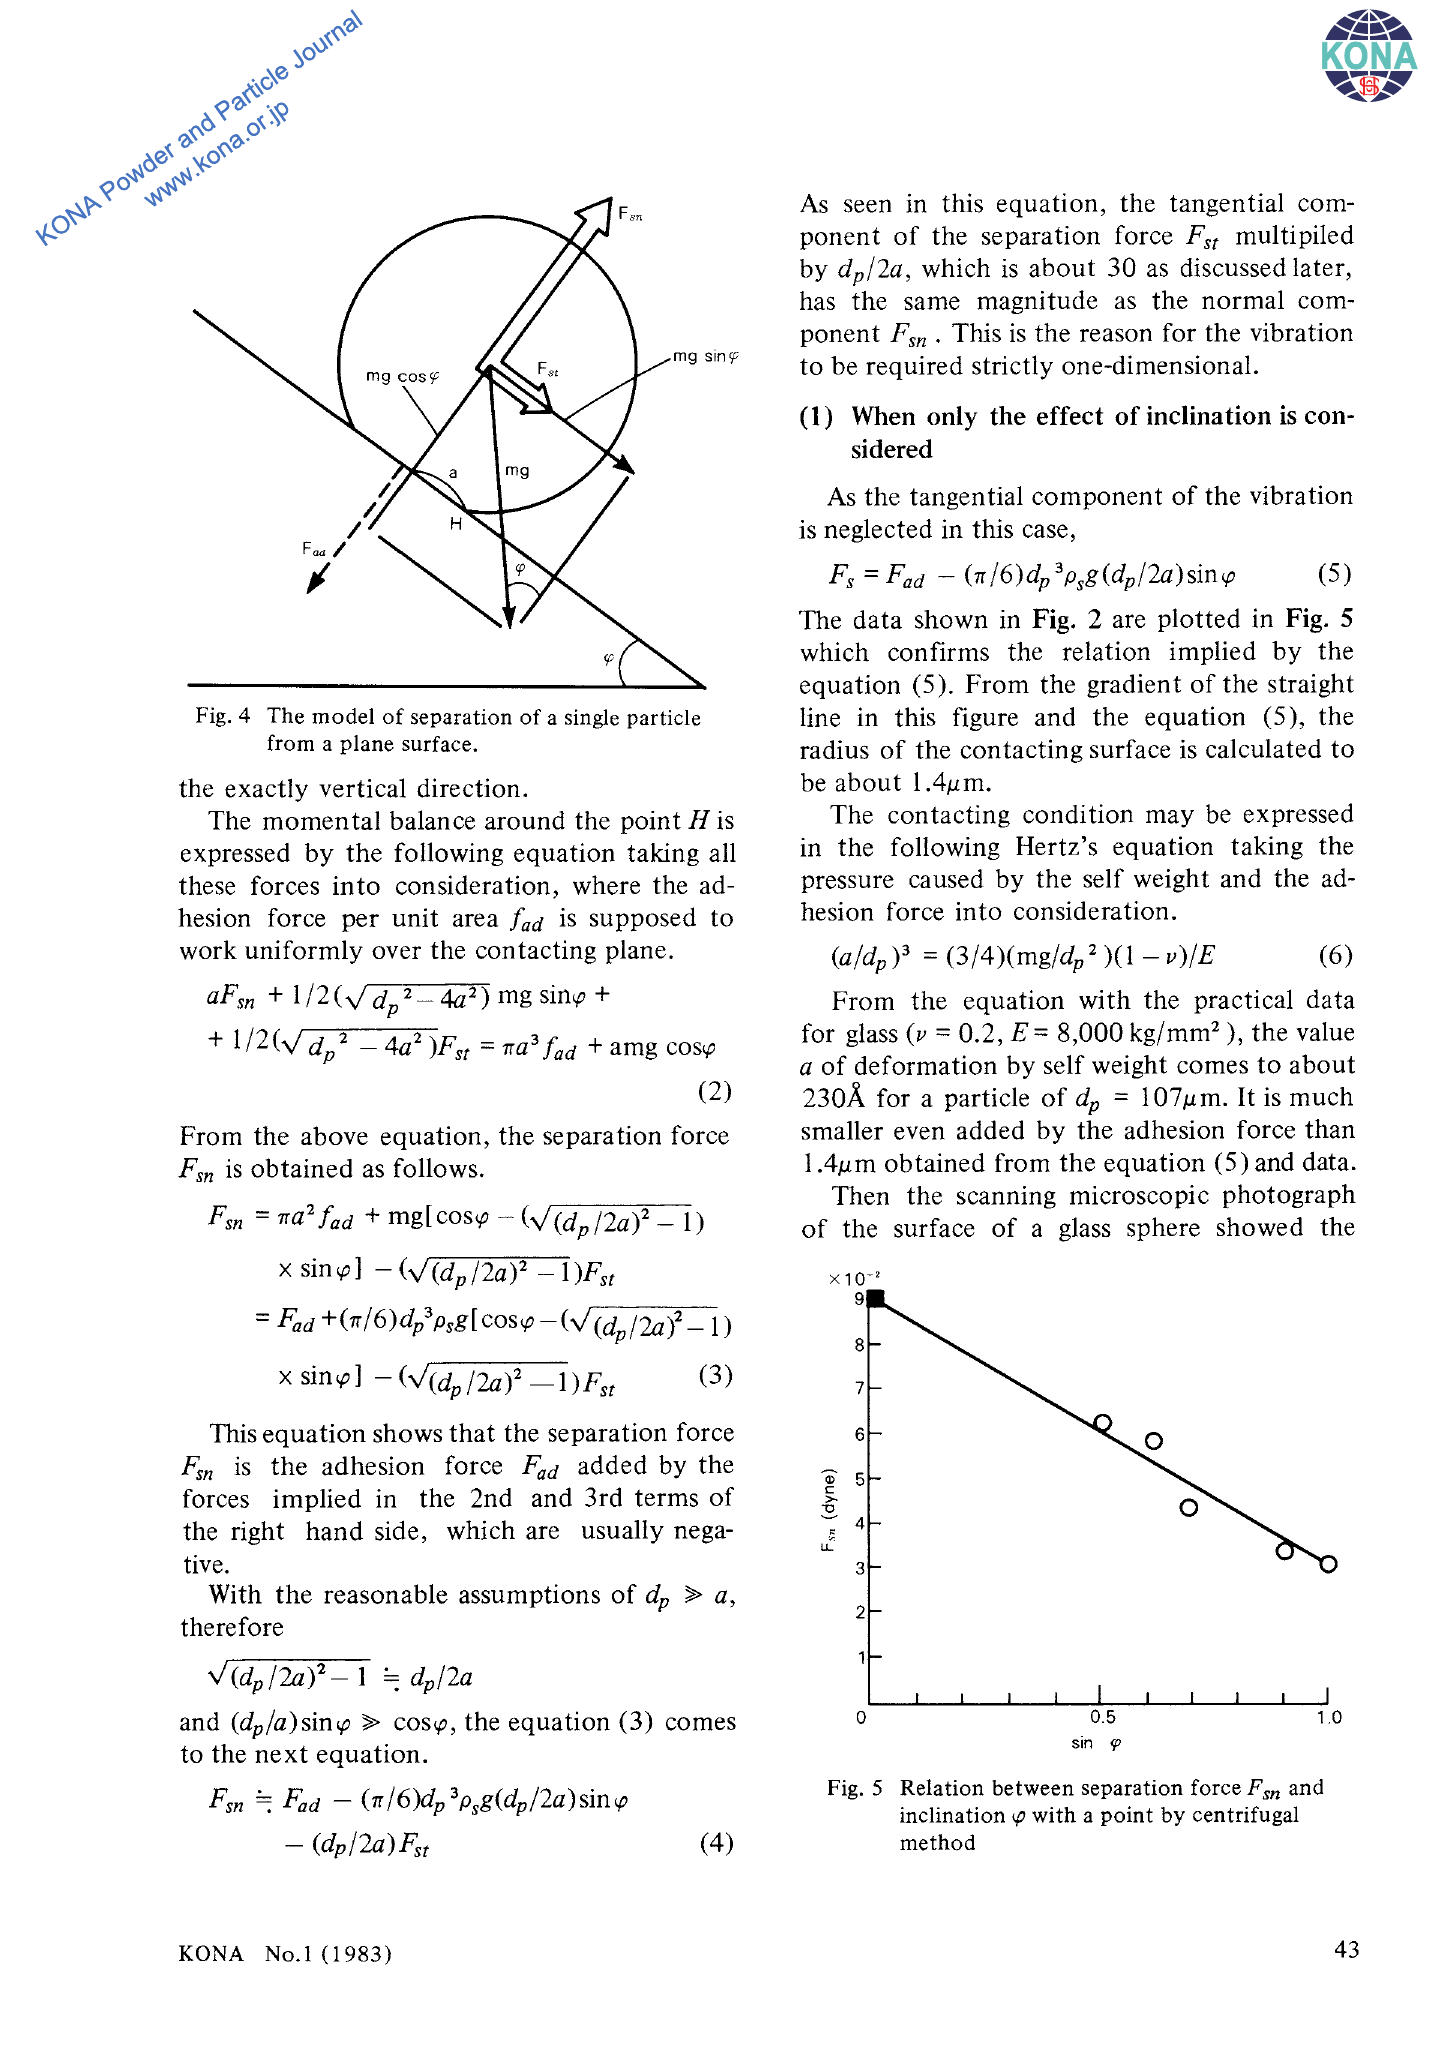
Fig. 5 Relation between separation force Fsn and inclination <P with a point by centrifugal